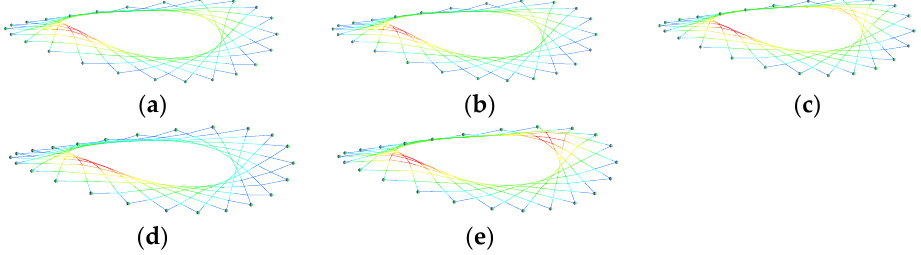
Figure 8. Vibration modes of schemes deleting one virtual ring. ( a ) SE1/1; ( b ) SE1/2; ( c ) SE1/3; ( d ) SE1/4; ( e )